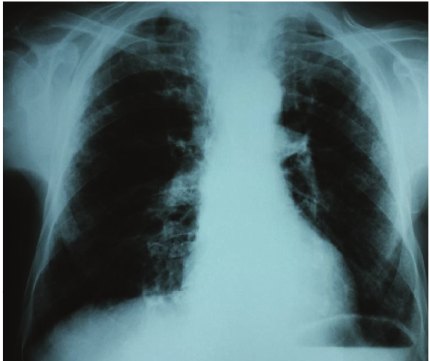
Figure 1: Chest X-ray conducted 24 years ago, displaying a trachea enlargement without any signs of fibrosis.